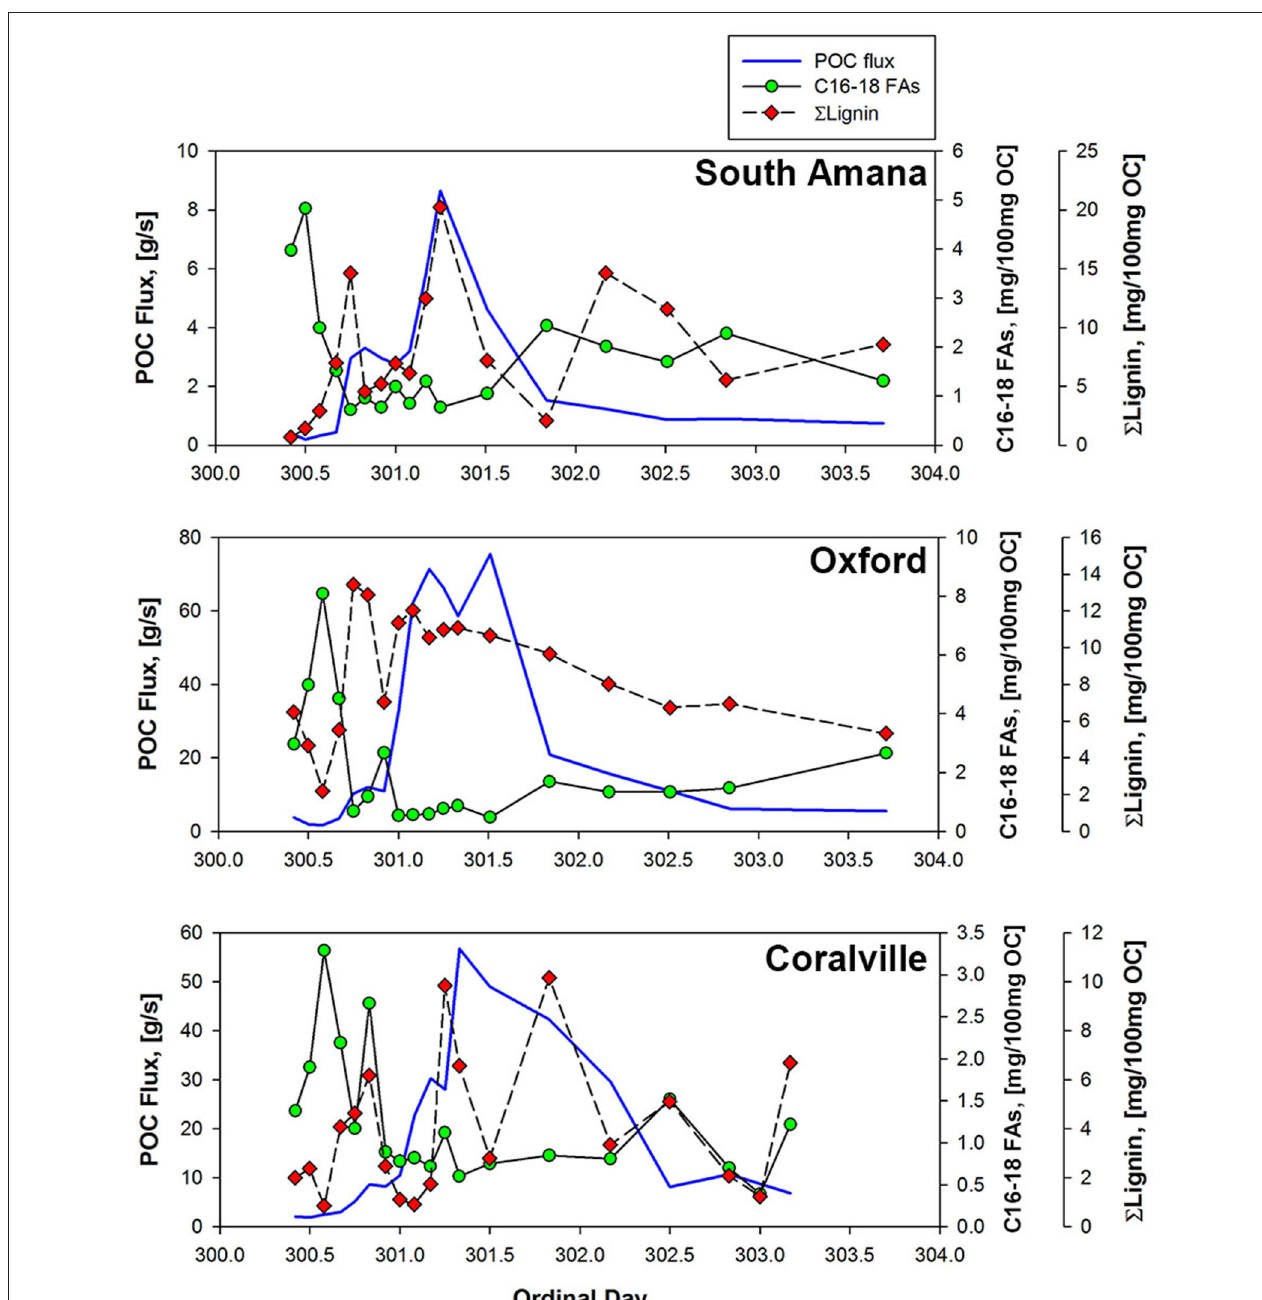
FIGURE 8 | POC fluxes and OC-normalized concentrations of lignin and C16-18 FAs at three sampling stations. From the upper panel on down, South Amana, Oxford, and Coralville.